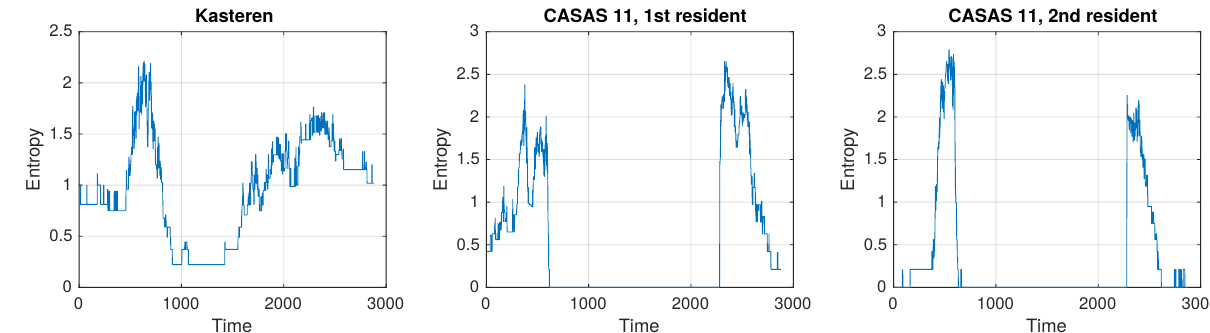
Figure 3. The entropy of activities at different times of the day for the Kasteren dataset, the first resident of the CASAS 11 dataset, and the second resident of the CASAS 11 dataset. A day starts at 4 a.m. on one calendar day and ends at 4 a.m. on the next calendar day. In the CASAS 11 dataset, entropy was calculated separately for each of the two residents. It was calculated every half minute.